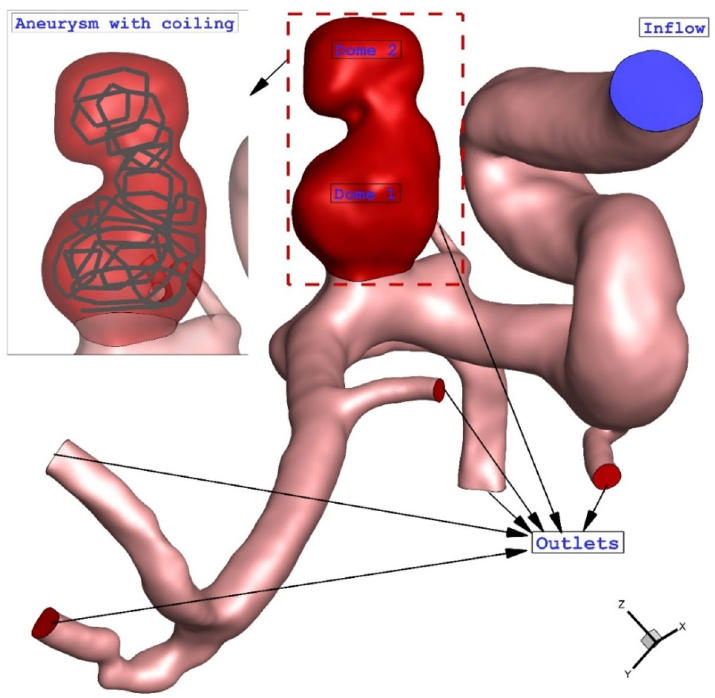
Figure 1. Schematic selected